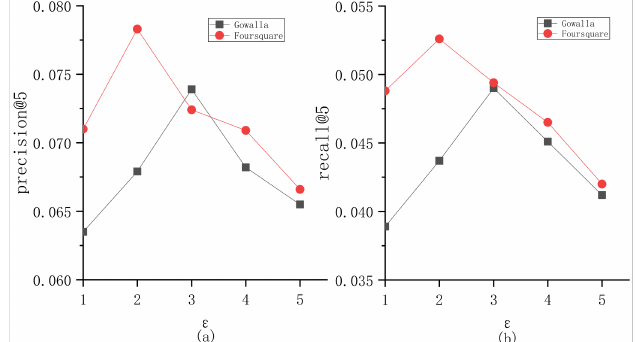
Figure 7. The sensitivity analysis of ε . ( a ) precision @5; ( b ) recall @5.